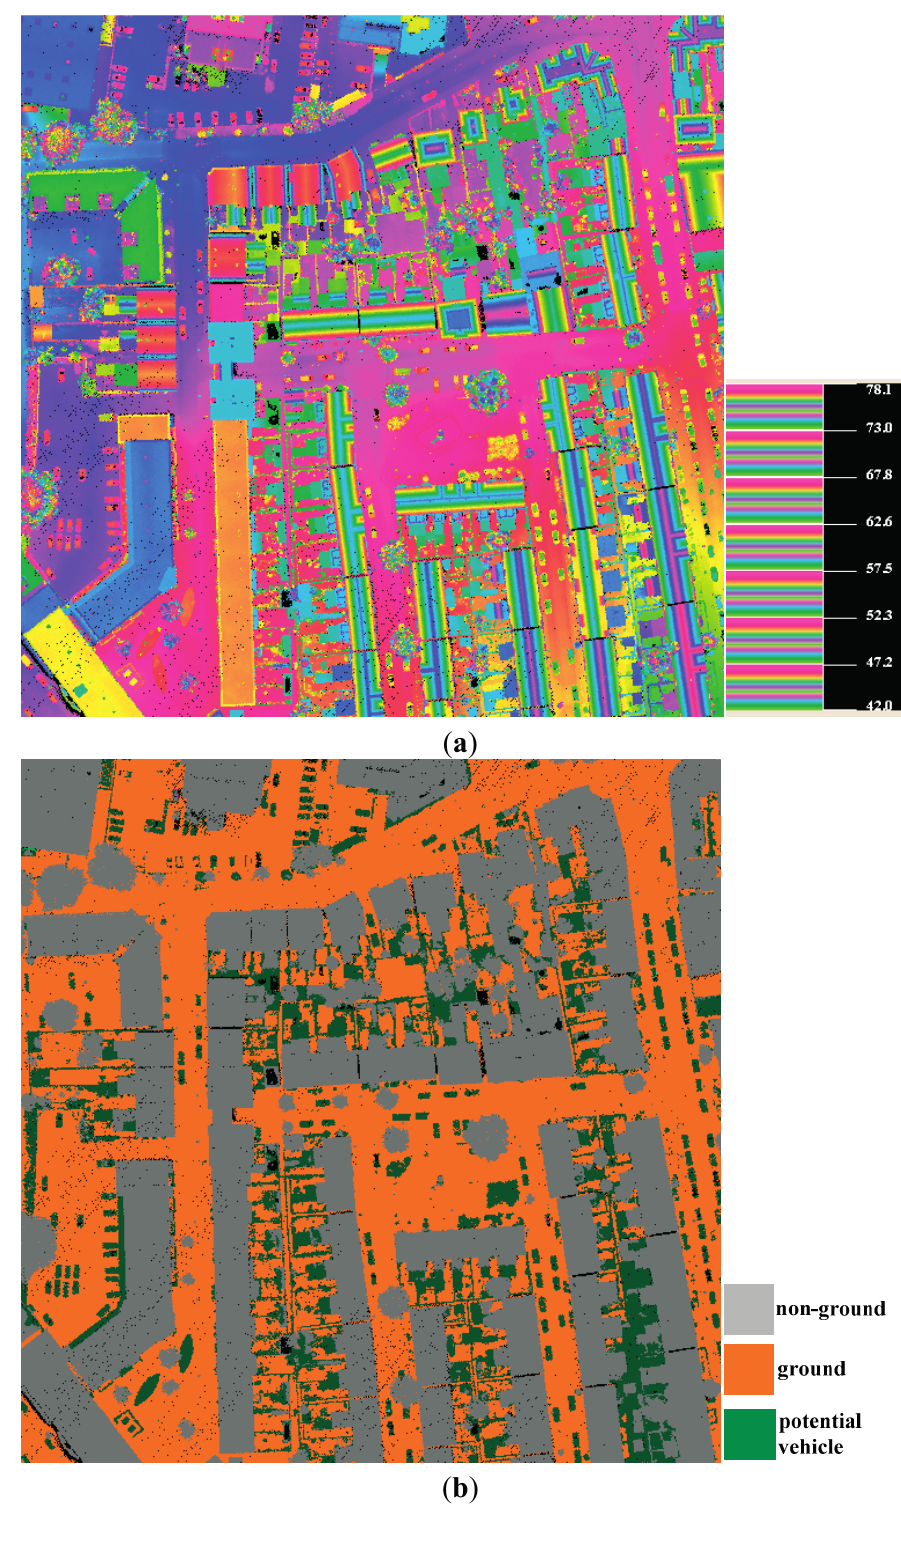
Figure 1. The testing point cloud and the potential vehicle points. ( a ) The testing point cloud with a density of 40 points/m 2 . ( b ) The filtering result by the method in [7] and the potential vehicle points. Note that the background color is set in black, and the black holes have no